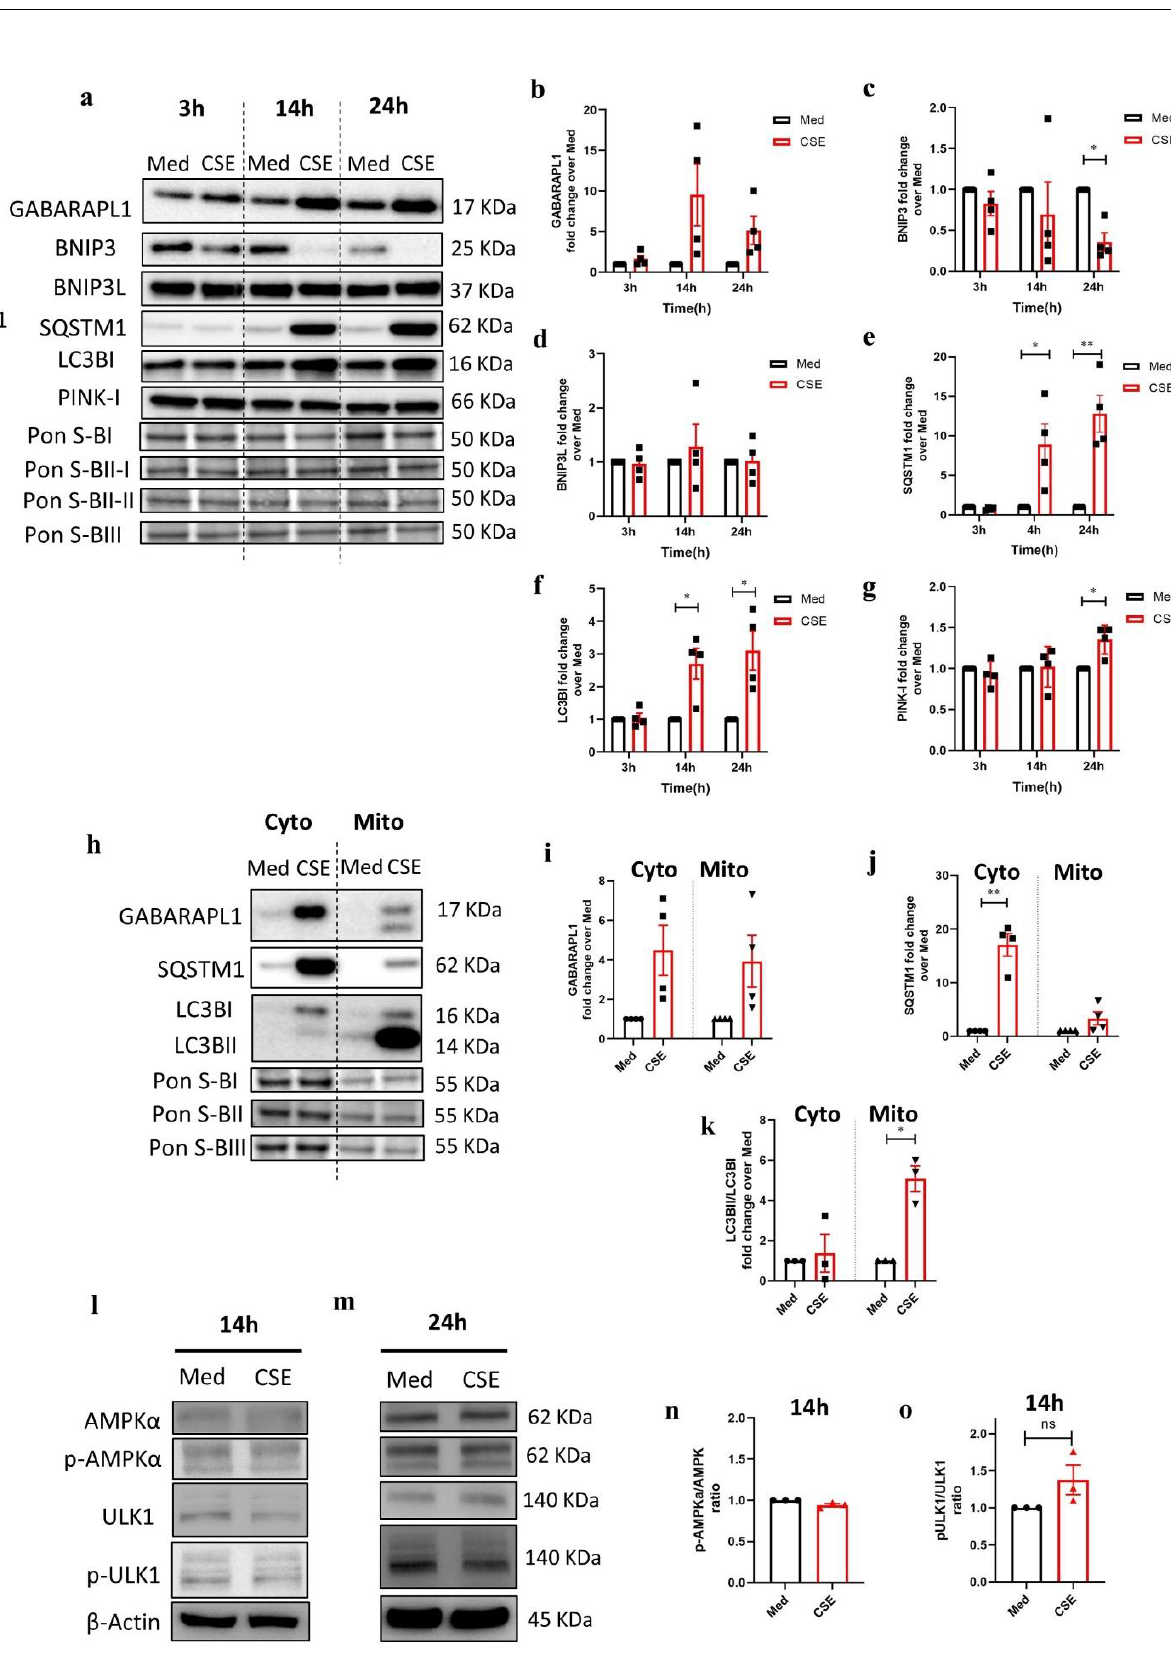
Figure 2. Abundance of key regulators involved in mitochondrial-specific autophagy (mitophagy) in 16HBE cells upon stimulation with cigarette smoke extract. ( a ) Immunoblots representing protein expression of receptor-mediated constituents gamma-aminobutyric acid A receptor-associated pro- tein-like 1 (GABARAPL1), BCL2-interacting protein 3 (BNIP3), BCL2-interacting protein 3-like (BNIP3L), and ubiquitin-mediated mitophagy factor phosphatase and tensin homolog (PTEN)-